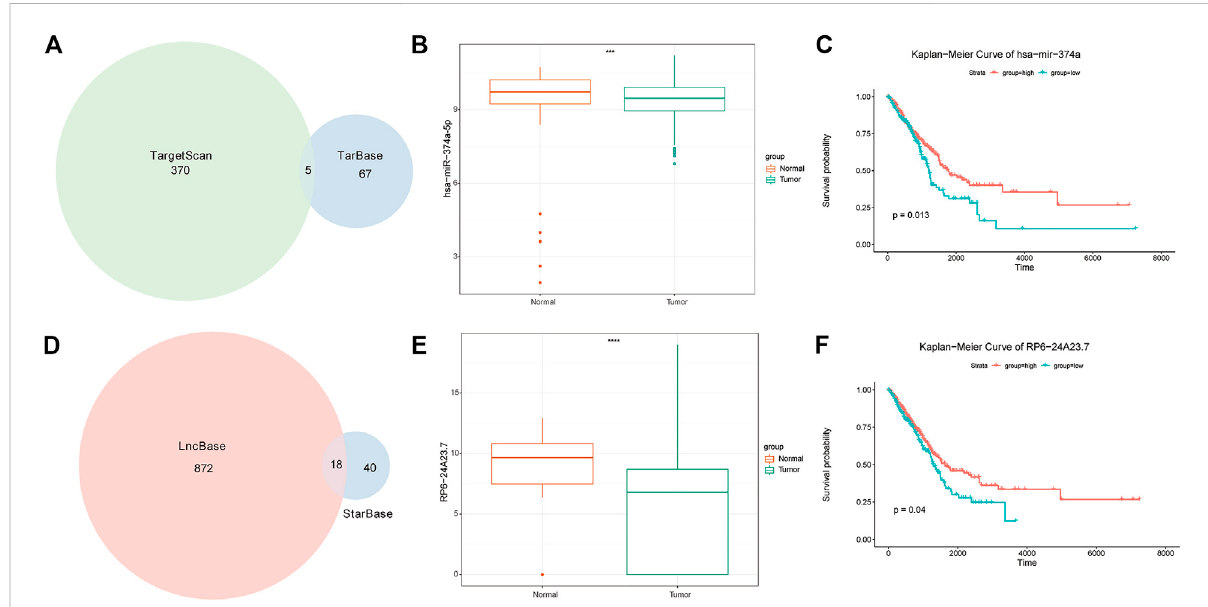
FIGURE 10 ceRNAanalysisresults. (A) VenndiagramofmiRNAintersectionofmiRNAsintargerScanandtarbasedatabases. (B) mRNAexpressiondifference between tumor group and normal group. (C) Survival analysis of miRNAs in high-risk and low expression groups. (D) Venn diagram of theinteraction ofmiRNAsinlncBasepredictedv2andstarBaseV2. (E) LncRNAexpressiondifferencebetweentumorgroupandnormalgroup.Survivalanalysisof (F) LncRNA in high and low expression